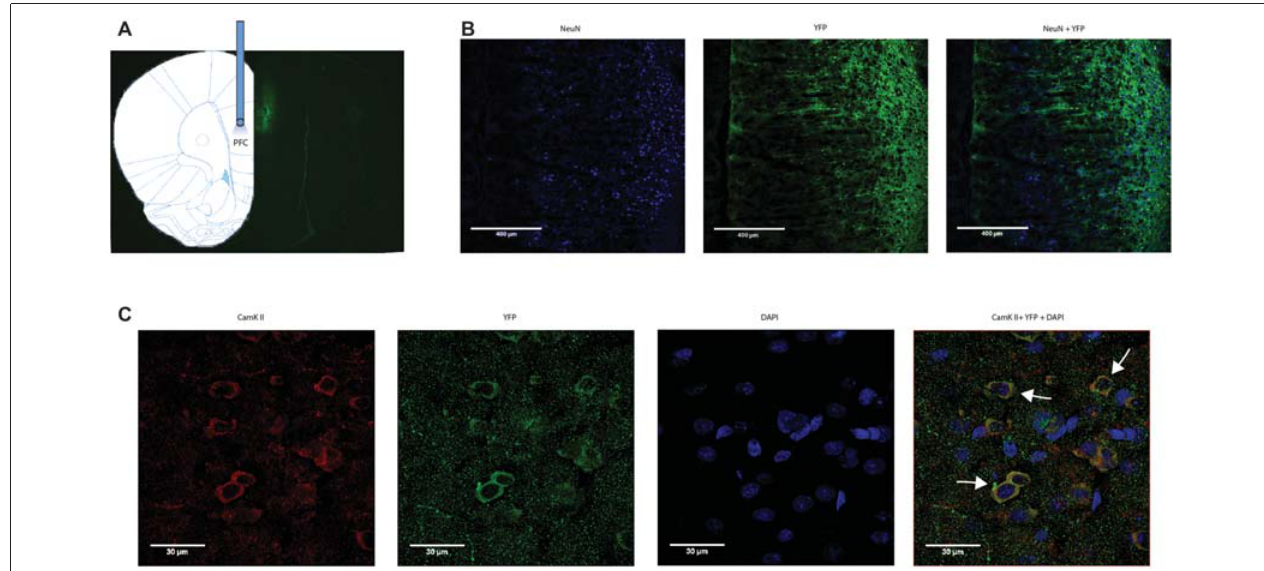
FIGURE 1 | Functional expression of channelrhodopsin-2 (ChR2) in prefrontal cortex (PFC) neurons. (A) A representative brain slice shows histologic expression of ChR2-enhanced yellow fluorescent protein (eYFP) in the prelimbic region of the PFC (PL-PFC) 2 weeks after viral injection. ChR2-eYFP expression and fiber location were found to be restricted to neurons in the PL-PFC region. (B) Images of PL-PFC at 20x magnification. Neurons were co-stained with NeuN and YFP. (C) Images taken of PL-PFC stained with CAMKII, YFP, and DAPI at 100x magnification. Arrows indicate co-staining of CAMKII and YFP.